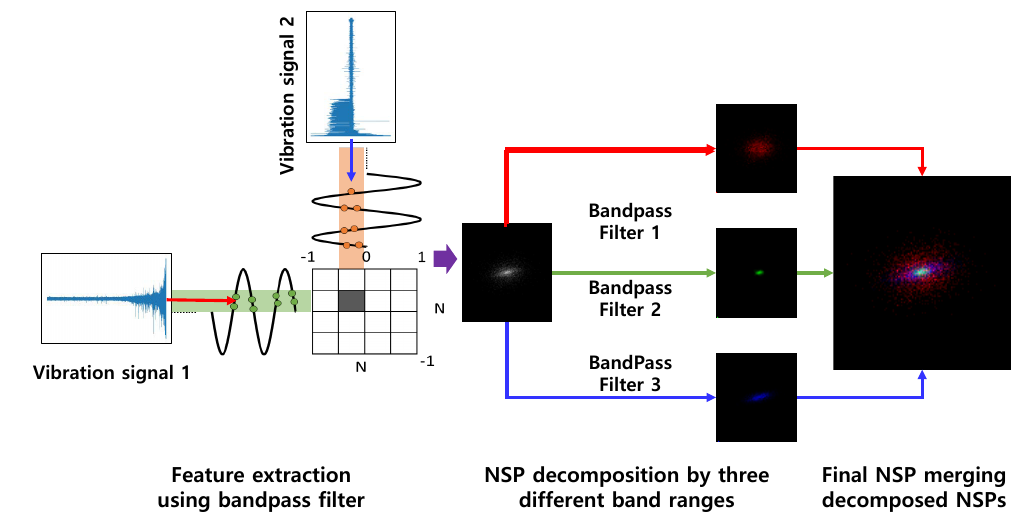
Figure 2. Nested-scatter plot image (NSP) methods and application to vibration signals.